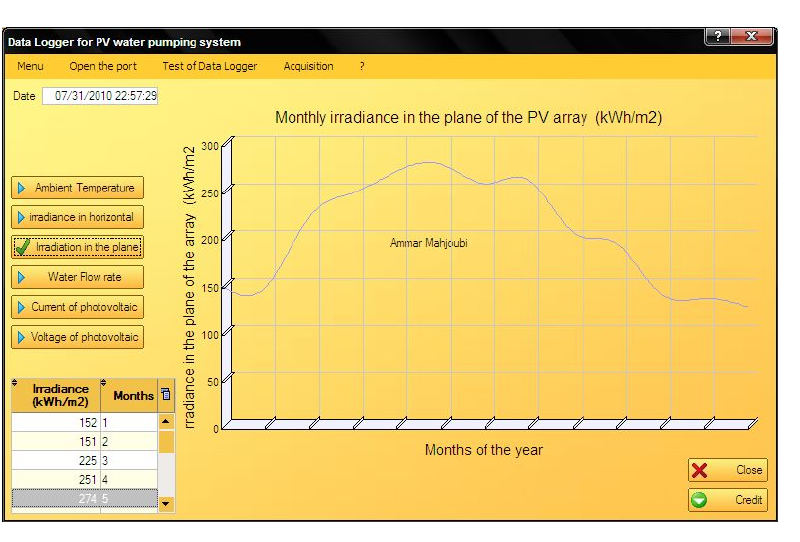
Figure 22. Variation of mean monthly irradiance in the plane of the PV array of the year 2009.